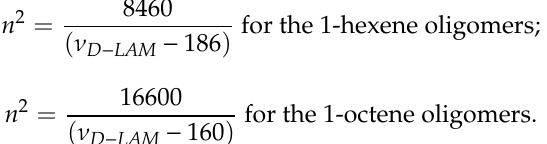
Table S1: Orbital and auxiliary basis sets for program PRIRODA (4z.bas), Table S2: Atomic Cartesian coordinates for hydrogenated 1-hexene and 1-octene dimer conformations with the lowest energies, Table S3: The calculated total energy E and total energy E 0 corrected for the zero point vibration energy (ZPVE) for hydrogenated 1-hexene and 1-octene dimer conformations, and the di ff erences ∆ E, ∆ E 0 between the energies of the corresponding and extended conformations, Table S4: The calculated Raman spectra for hydrogenated 1-hexene and 1-octene dimer conformations with the lowest energies. Video S1: In-phase.mp4, Video S2: